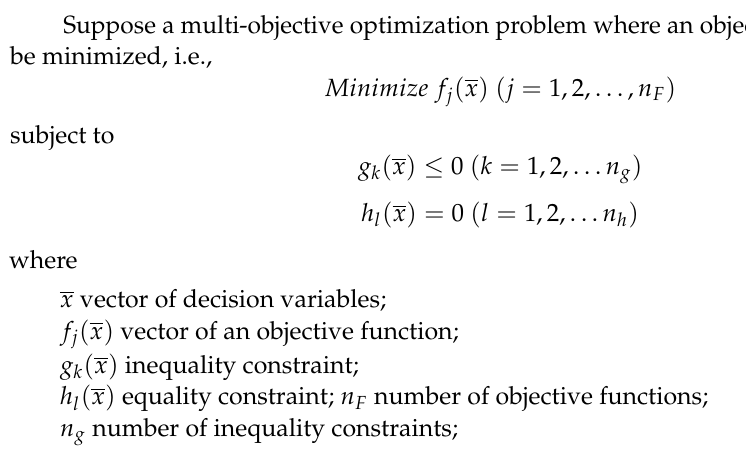
Figure 2. NDSs in a two-objective